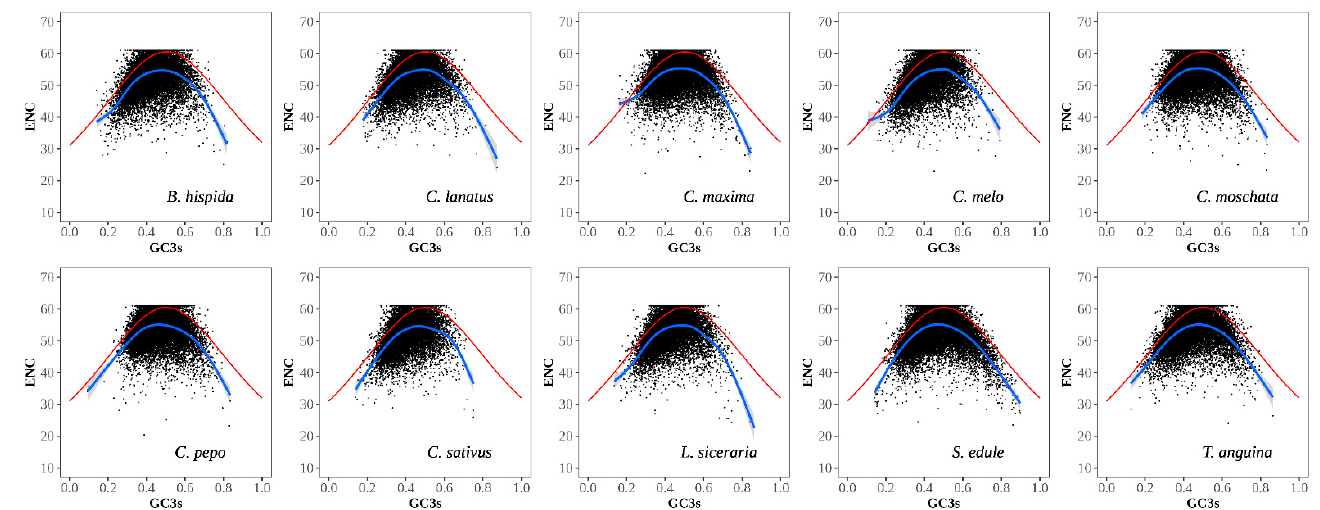
Figure 6. Distribution of ENC and GC3s of genes in ten species of Cucurbitaceae. Note: the solid red curve indicates the expected ENC value. ENC exp = 2 + GC3s + 29/(GC3s 2 + (1 − GC3s) 2 ). The solid blue curve represents the fitting curve.